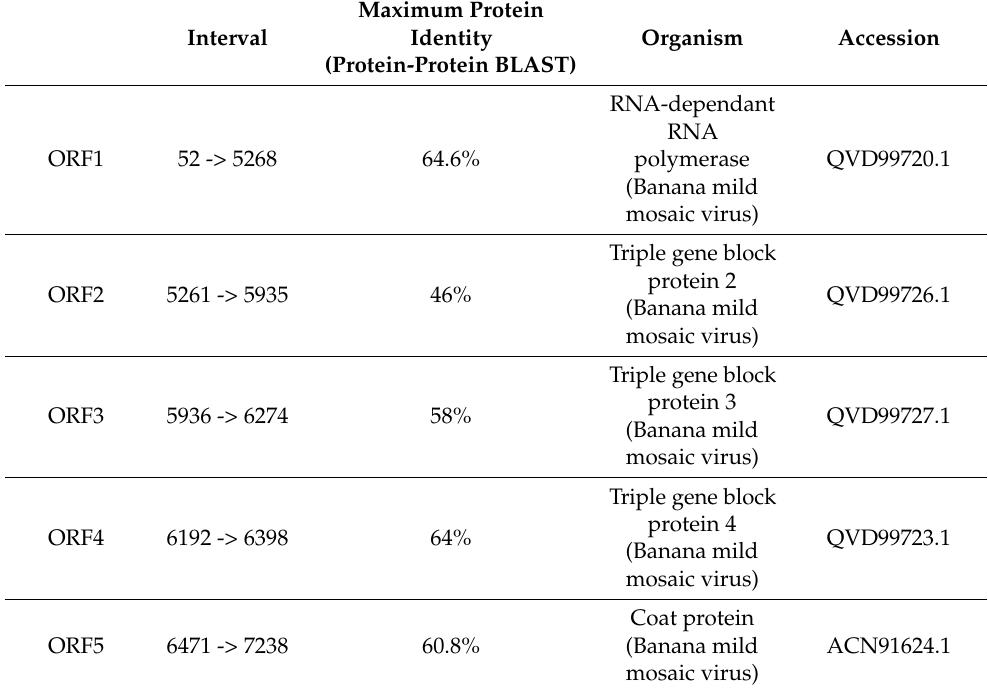
Table 6. BLASTP results of the five ORFs of the new Betaflexiviridae